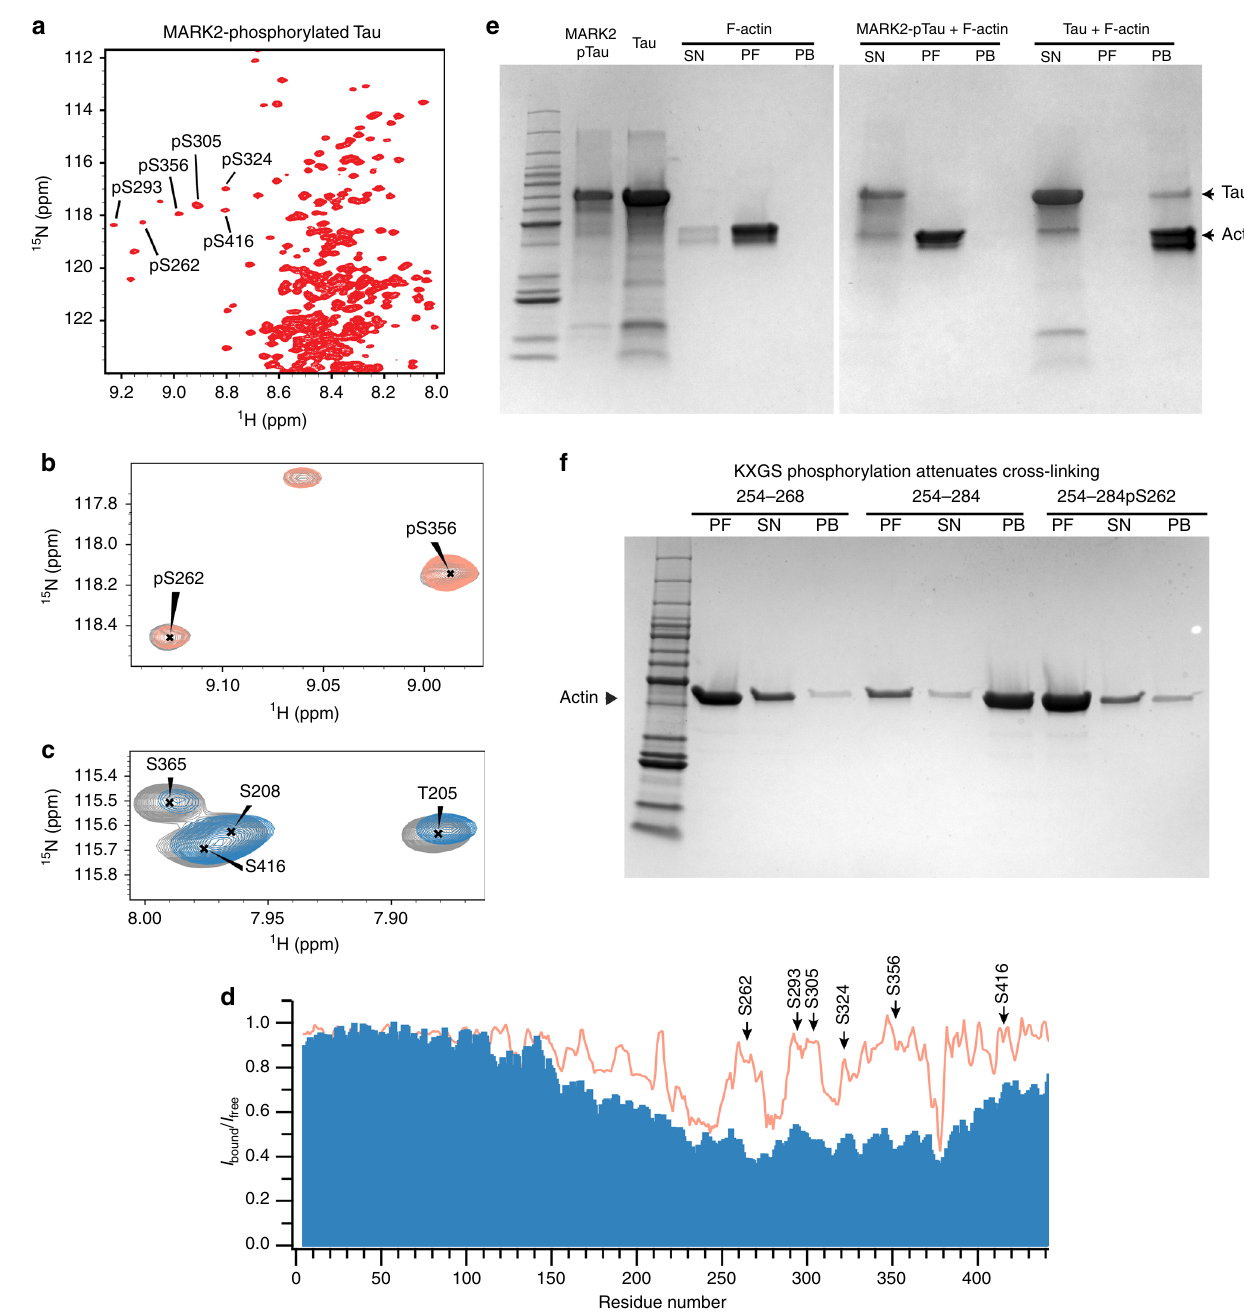
Fig. 4 MARK2 phosphorylation decreases Tau ’ s af fi nity for F-actin. a 1 H- 15 N HSQC of MARK2-phosphorylated Tau. Phosphorylated serine residues are labeled. b Selected region from a 1 H- 15 N HSQC of MARK2-phosphorylated Tau in the absence (gray) and presence of F-actin (orange; Tau/F-actin molar ratio of 1:1.5). c Selected region from a 1 H- 15 N HSQC of non-phosphorylated Tau in the absence (gray) and presence of F-actin (blue; Tau/F-actin molar ratio of 1:1.5). d NMR signal broadening induced by F-actin in non-phosphorylated (blue bars) and MARK2-phosphorylated Tau (orange line). Tau residues phosphorylated by MARK2 are highlighted. e Effect of MARK2-phosphorylation on the ability of Tau to bundle actin fi laments. f Phosphorylation of S262 decreases the ability of Tau(254 – 284) to bundle